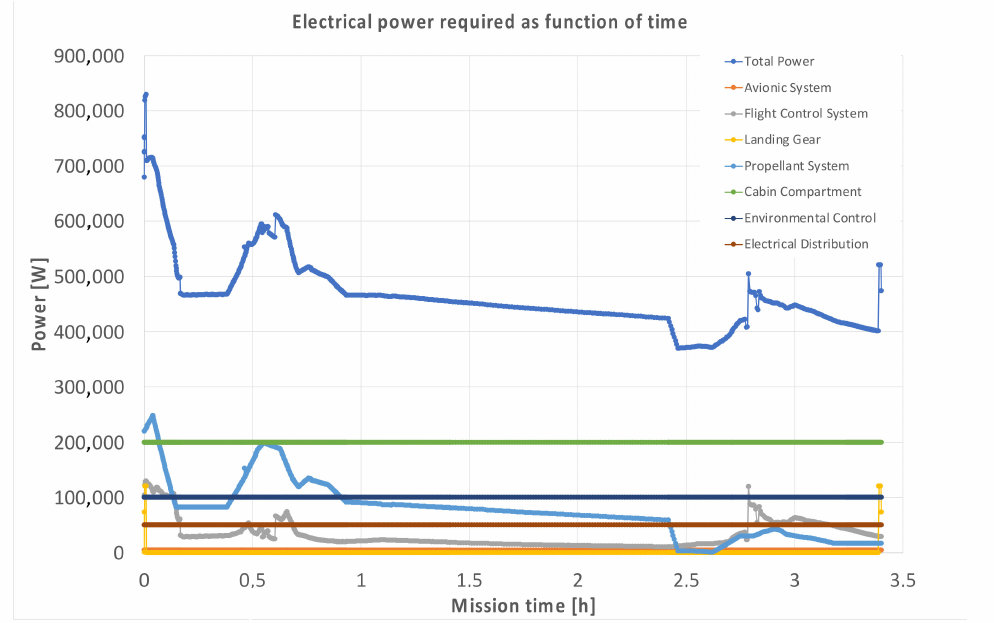
Figure 9. STRATOFLY MR3 power